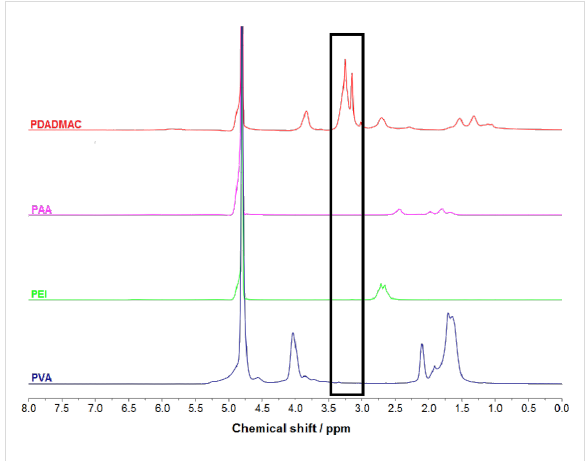
Figure 5: 1 H NMR spectra of solutions (50 mM monomer conc.) of PDADMAC, PAA, PEI, and PVA (from top to bottom). Quantification